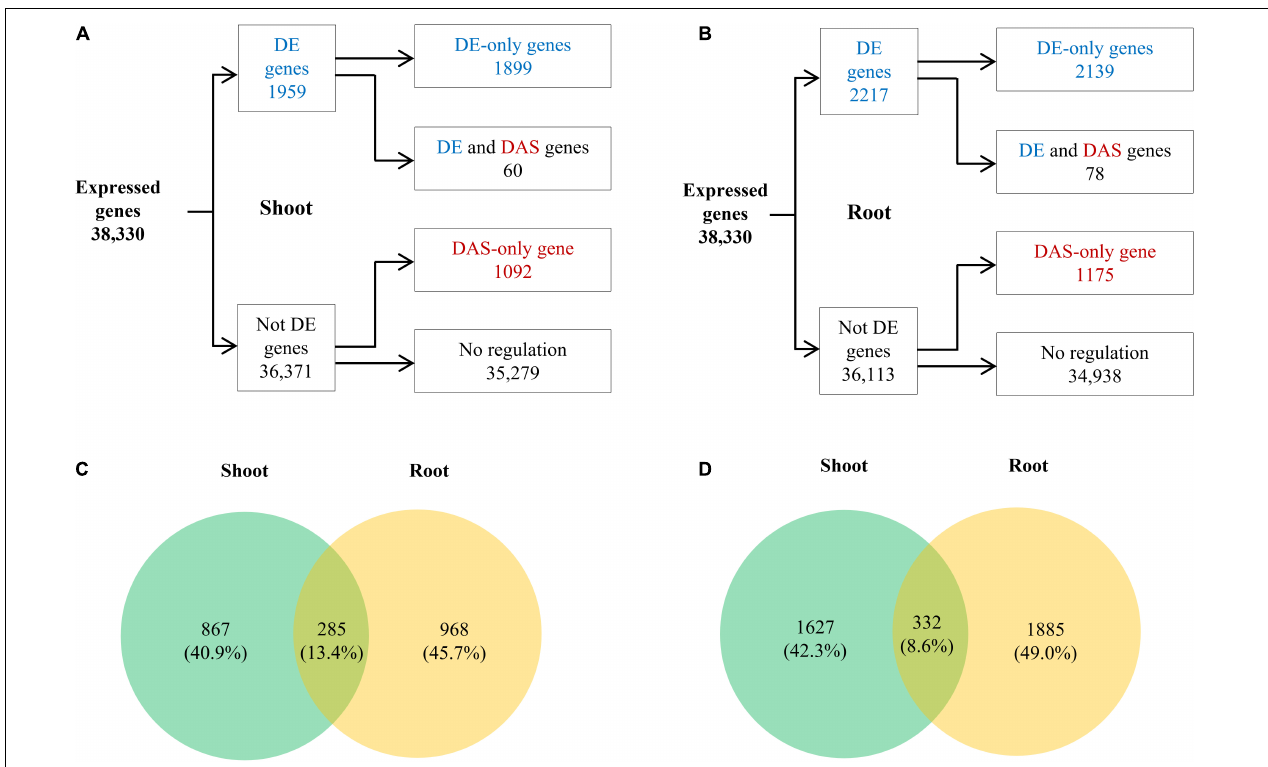
FIGURE 6 | Differentially expressed (DE) and DAS analyses of tobacco in response to low K + stress. (A) Flow chart showing the distribution of the DE (blue) and DAS (red) genes in shoots; (B) Flow chart showing the distribution of the DE (blue) and DAS (red) genes in roots; (C) Venn diagram of DAS genes in shoots and roots; (D) Venn diagram of DE genes in shoots and